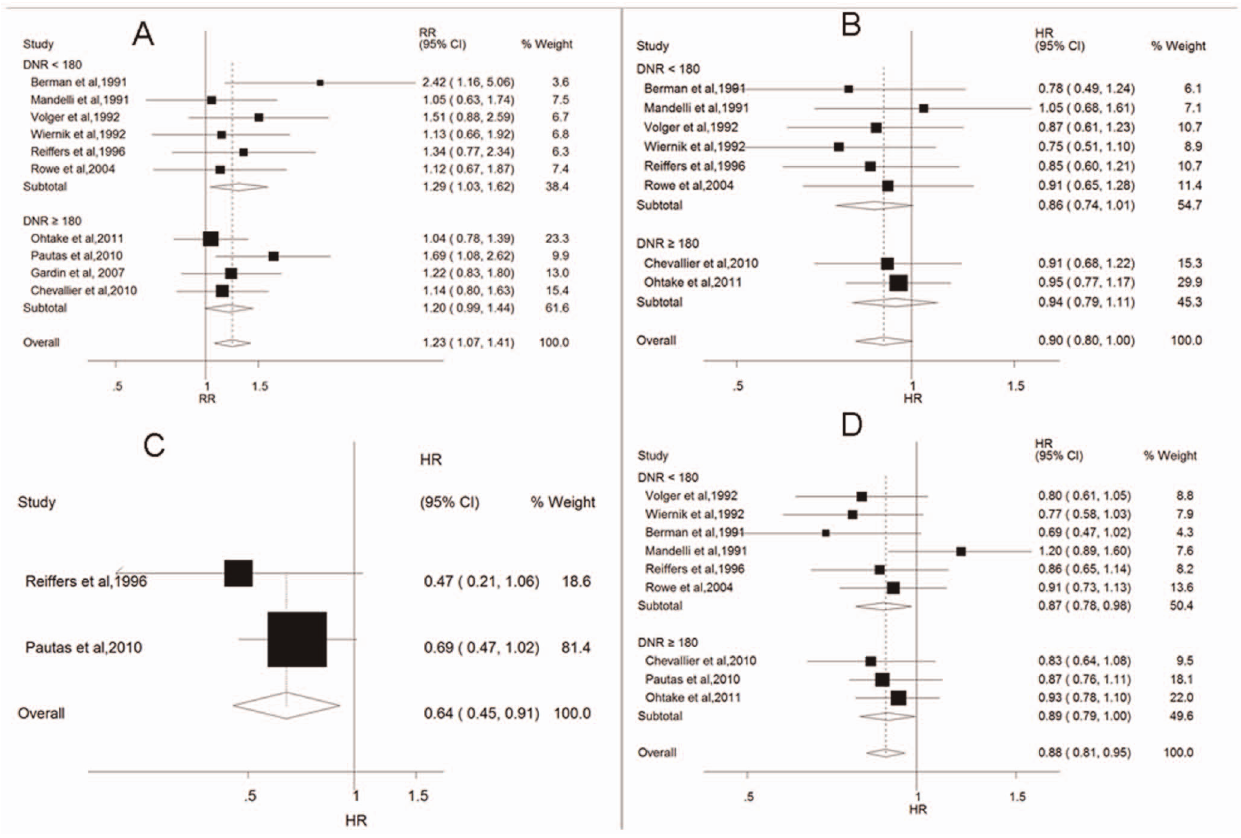
Figure 2. Forest plot of the RR/HR. The size of the squares reflects each study’s relative weight, and the diamond ( e ) represents the aggregate RR/HR and 95% CI. (A) Complete remission ( p =0.004); (B) Disease-free survival ( p =0.06); (C) Event-free survival ( p =0.013); (D) Overall survival ( p =0.002).